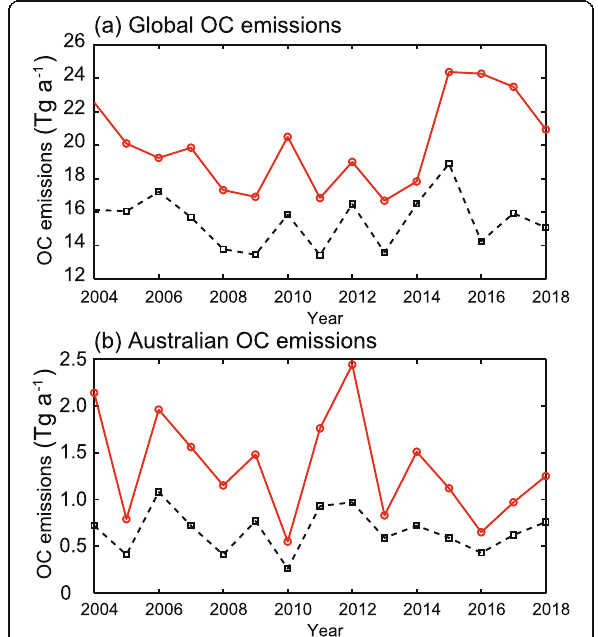
Fig. 1 Comparison of inter-annual variation in ( a ) global and ( b ) Australian organic carbon (OC) emissions (Tg a – 1 ) from biomass burning in this work (red lines with circle symbols) to GFED4.1s (dashed black lines with square